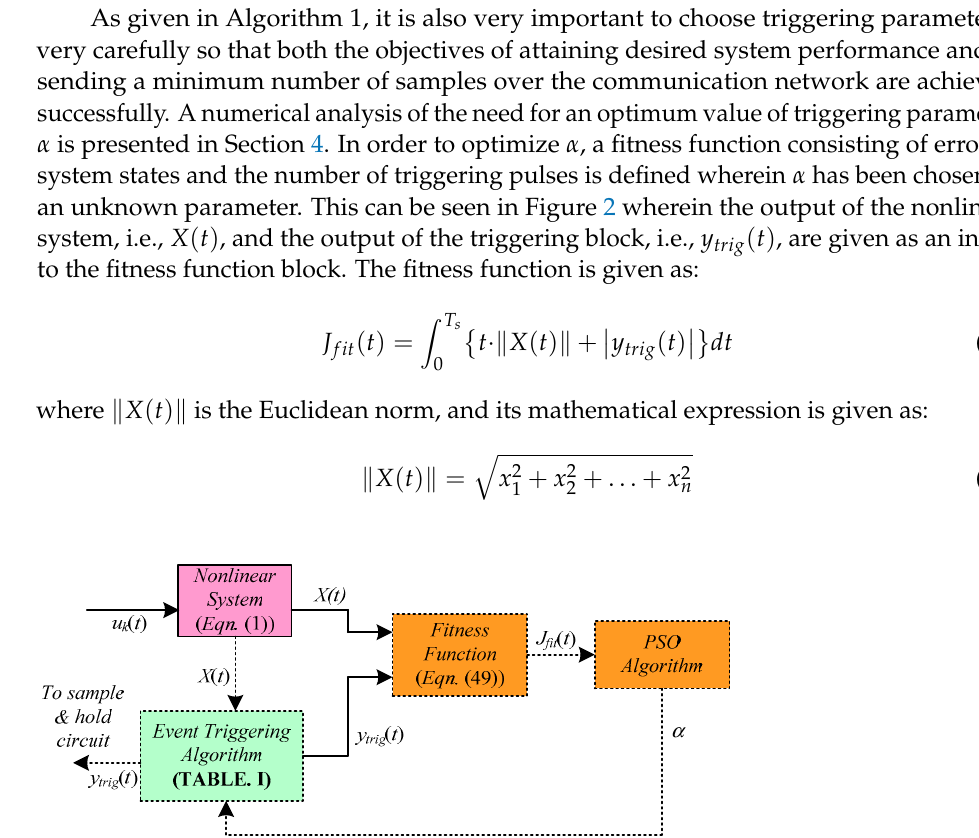
chosen to be (cid:1846) (cid:3046) .